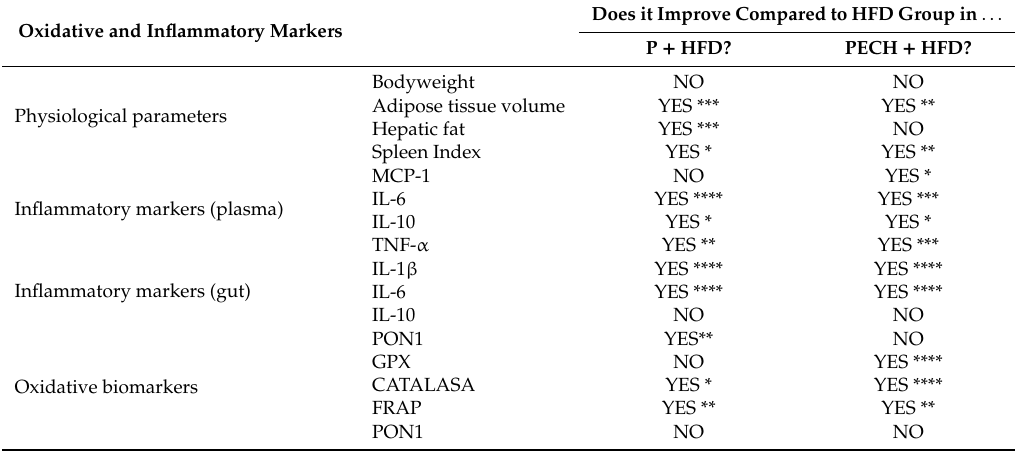
Table 3. Summary of comparisons between high fat diet group (HFD) and both phenolic enriched high fat diet (P + HFD) and phenolic enriched cooked ham high fat diet (PECH + HFD). Does it Improve Compared to HFD Group in Oxidative and Inflammatory Markers